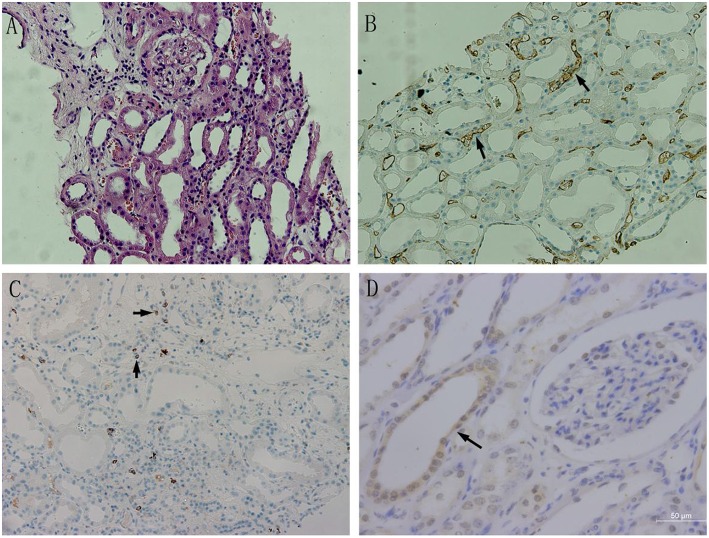
The BAFF expression in kidney tissues with acute rejection. (A) Acute humoral rejection (HE, ×200): swollen glomerular endothelial cells, degenerated tubular epithelial cells,shed brush borders, and mononuclear lymphocytes and erythrocyte deposits in the perivascular capillaries. (B) C4d expression in transplant kidney tissue (×200): C4d was strongly and linearly deposited at perivascular capillary basal membranes, and its deposition was also observed in the glomerular capillary lumen. (C) CD20 expression in transplant kidney tissue (×200):CD20-positive B lymphocytes were mainly accumulated at renal interstitium, exhibiting dispersive infiltration. (D) BAFF expression in transplant kidney tissue(×400). BAFF was mainly expressed on the membrane and cytoplasm of renal tubular epithelial cells.Positive staining was observed as a brown color.